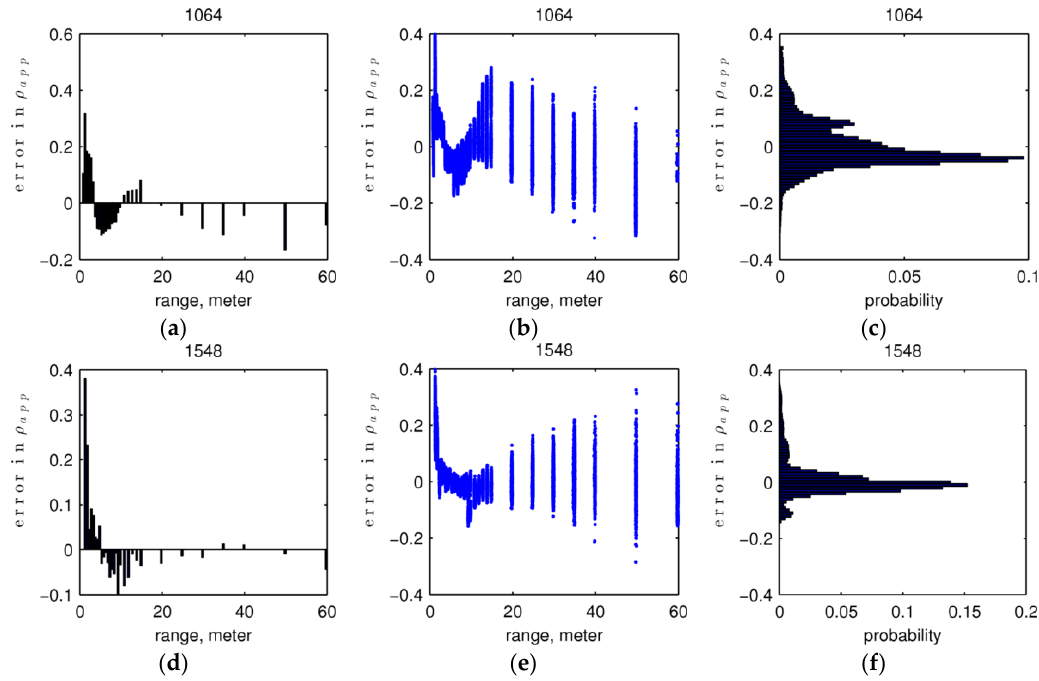
Figure 7. Errors in apparent reflectance. The first row ( a – c ) shows 1064 nm, and the second row ( d – f ) shows 1548 nm. The left column (a,d) is the deviation from calibration fitting with range. The middle (b,e) column is the deviation of validation points with range. The right column (c,f) is the histogram of deviations.